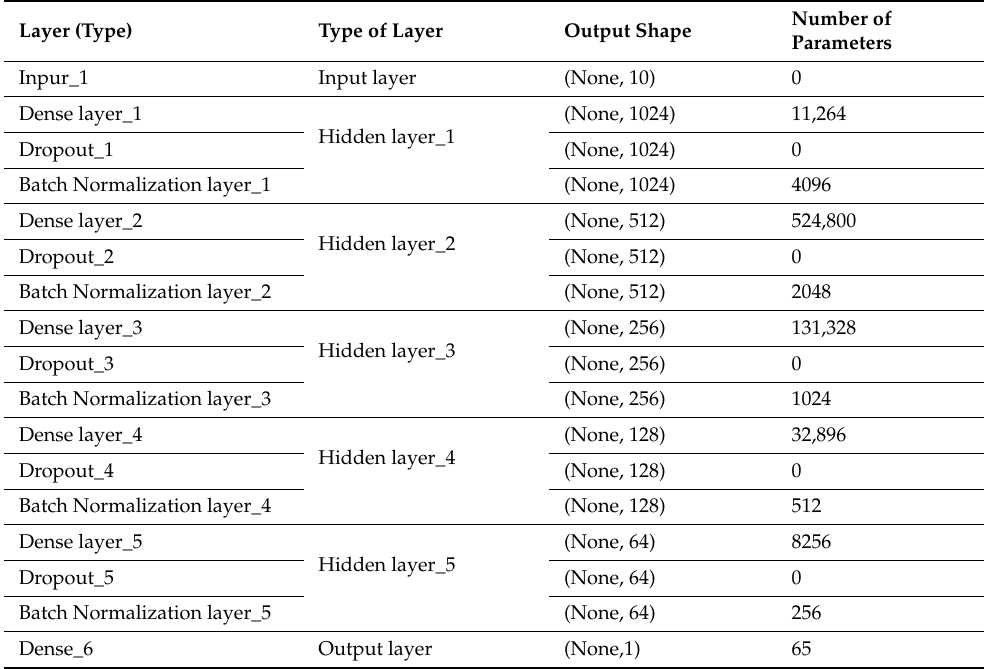
Table 2. Configuration of the DNN